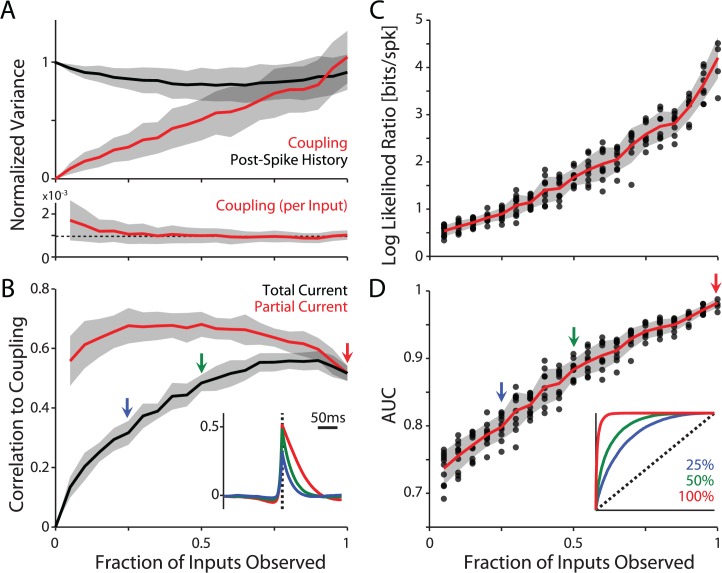
Modeling multiple inputs improves spike prediction and reveals a correlation between the model input and the injected current.A) The variance of the coupling terms and post-spike history relative to the variance of the estimated log rate, log λ(t), plotted against the fraction of inputs included in the model. As the fraction of observed inputs becomes larger, coupling describes a greater part of variations in the post-synaptic firing rate. However, the contribution of individual inputs remains relatively constant (lower) around 1/N (dashed line). B) Correlation between the coupling term and the total injected current (black), and the partial current (red, postsynaptic current that was produced by the fraction of inputs observed). Note that correlations between the coupling term and total current increase, while correlation between coupling and partial current remains consistently high. Inset illustrates the average cross-correlations between the coupling term and total current for models with 25, 50, and 100% of the inputs observed. C) Cross-validated log likelihood ratio of the full model relative to a homogeneous Poisson model as a function of the fraction of observed inputs (data for N = 4 cells, combined across postsynaptic firing rates of 1, 5, and 10 Hz). Points denote individual cells and firing rate conditions. Error bands denote standard deviation. D) Area-under-the-curve spike prediction accuracy, calculated from same data as in (C). Inset illustrates average ROC curves for model fits with 25, 50, and 100% of the inputs observed.